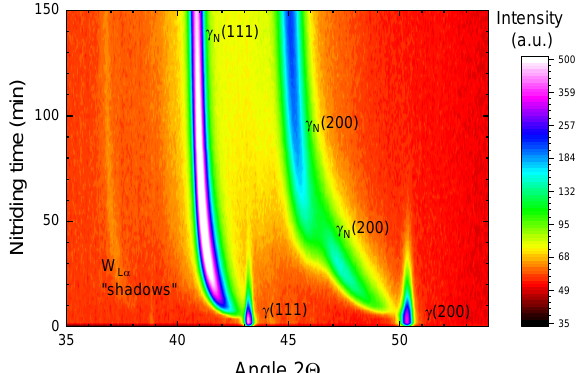
Figure 1. This is a contour plot of a series of successively measured X-ray diffraction (XRD) spectra, showing the phase evolution as a function of nitriding time at 450 °C substrate temperature using steel alloy 1.4571 at a nitrogen ion current density of 60 µA/cm 2 .